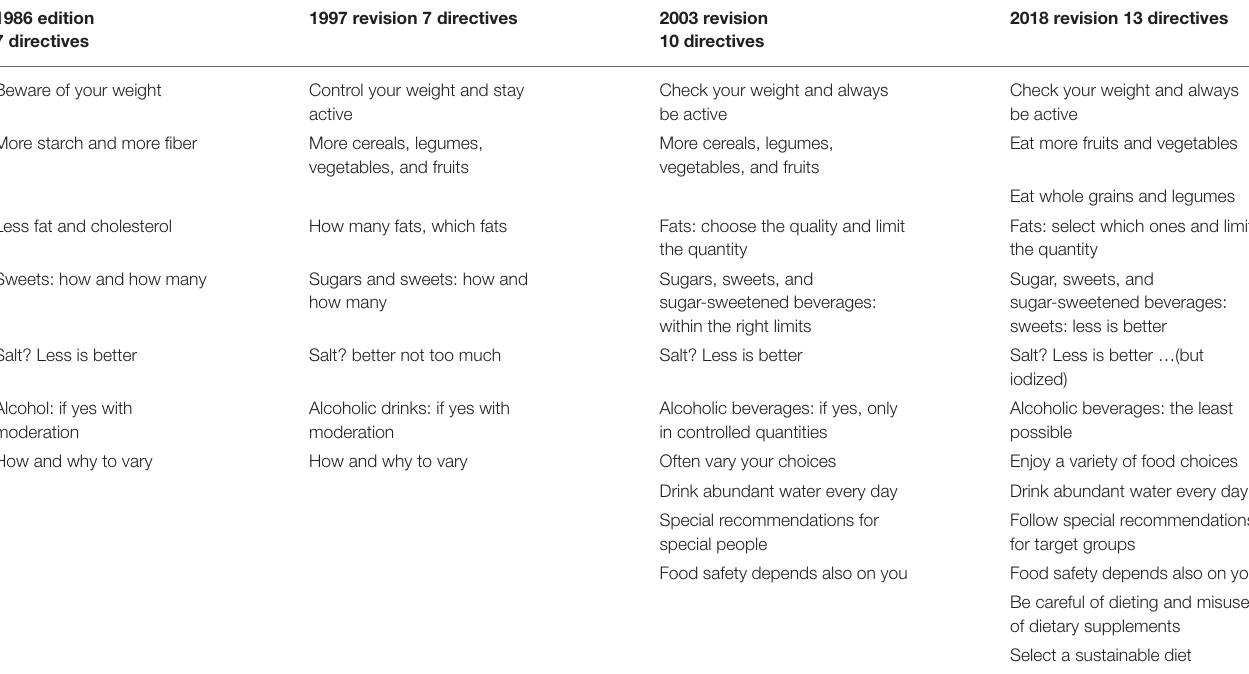
TABLE 2 | Language, length, and recommendation changes of Italian Dietary Guidelines (IDGs) revisions since